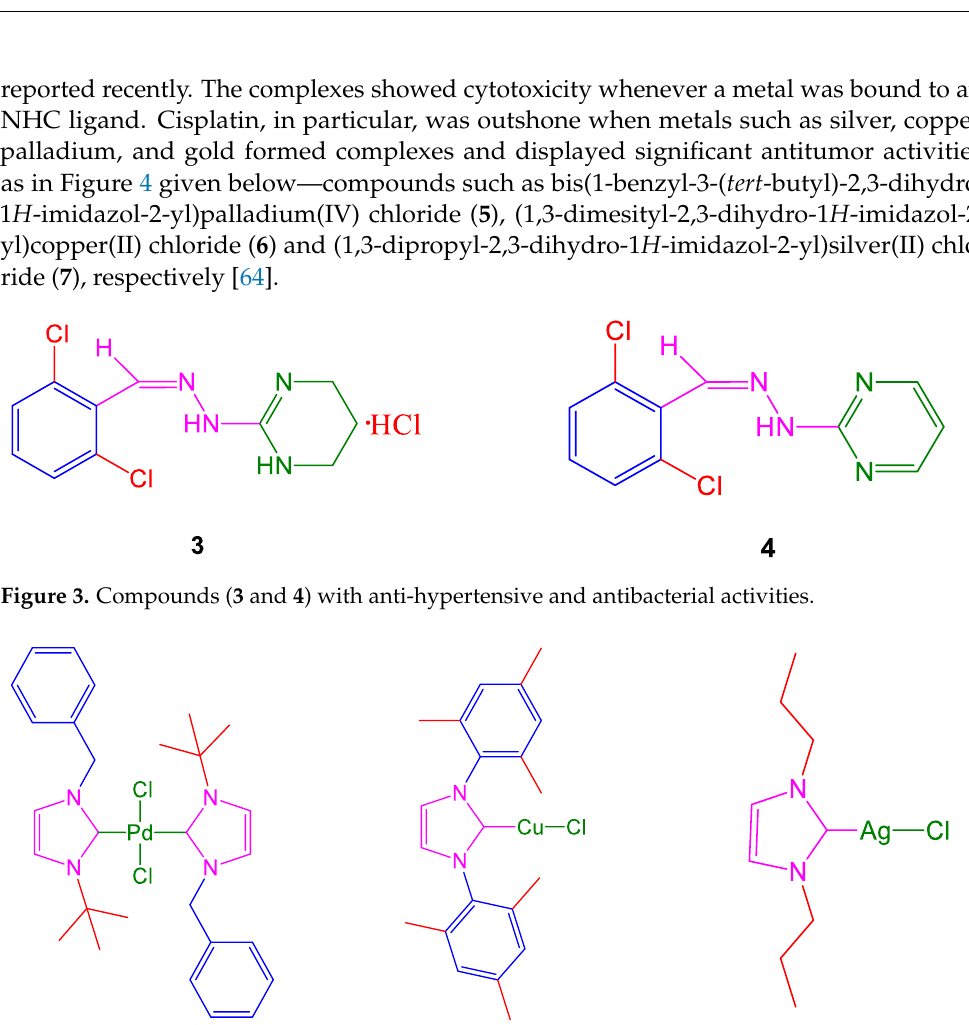
Figure 4. Structures of metal complexes of N -heterocyclic carbene compounds ( 5 – 7 ).